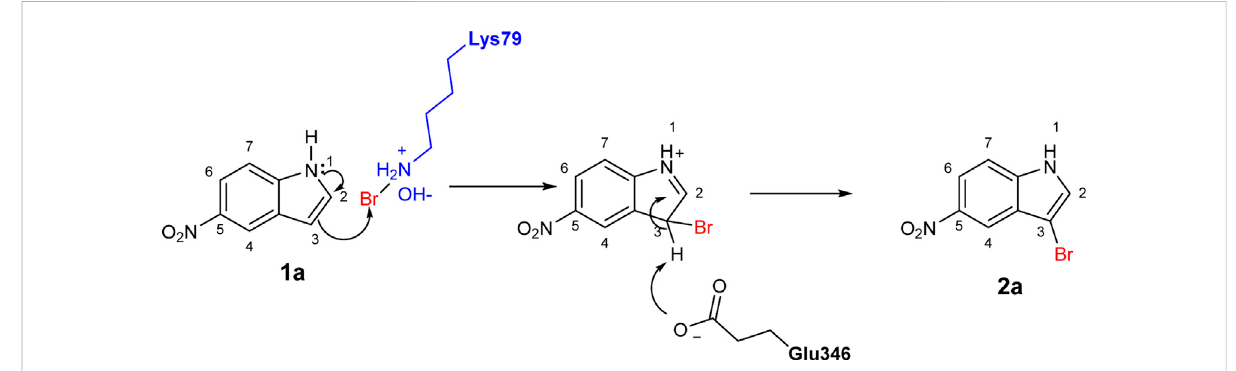
FIGURE 3 Proposed mechanism of 3-LSR catalyzed indole